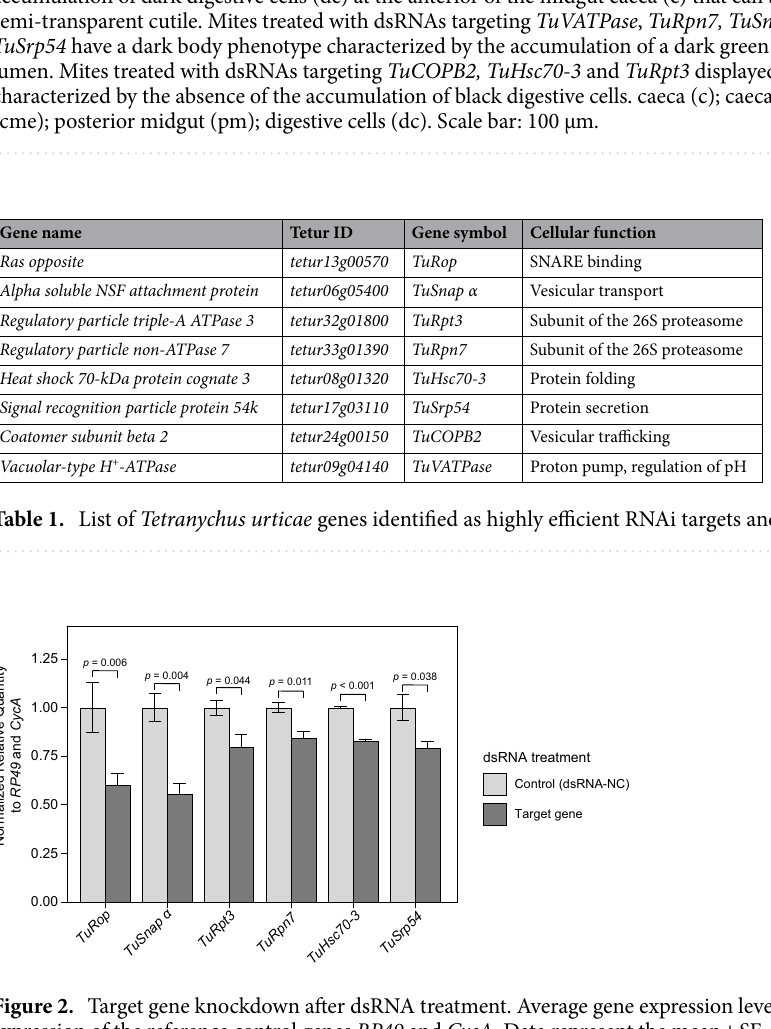
Figure 2. Target gene knockdown after dsRNA treatment. Average gene expression level relative to the expression of the reference control genes RP49 and CycA . Data represent the mean ± SE. The RT-qPCR analysis was assessed at the whole mite level and was conducted in three independent experimental runs. Statistical analysis was performed using unpaired two-tailed t test (exact P -values corresponding to each pairwise comparison between the control and the treatment are